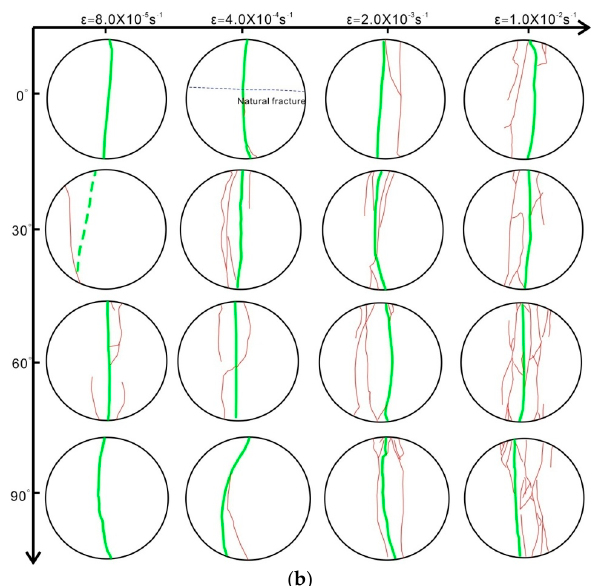
Figure 6. Fracture pattern description of typical shale sample with different orientations at strain rate of 8 × 10 − 5 s − 1 , 4 × 10 − 4 s − 1 , 2 × 10 − 4 s − 1 , and 1 × 10 − 2 s − 1 , respectively (the green line indicates main